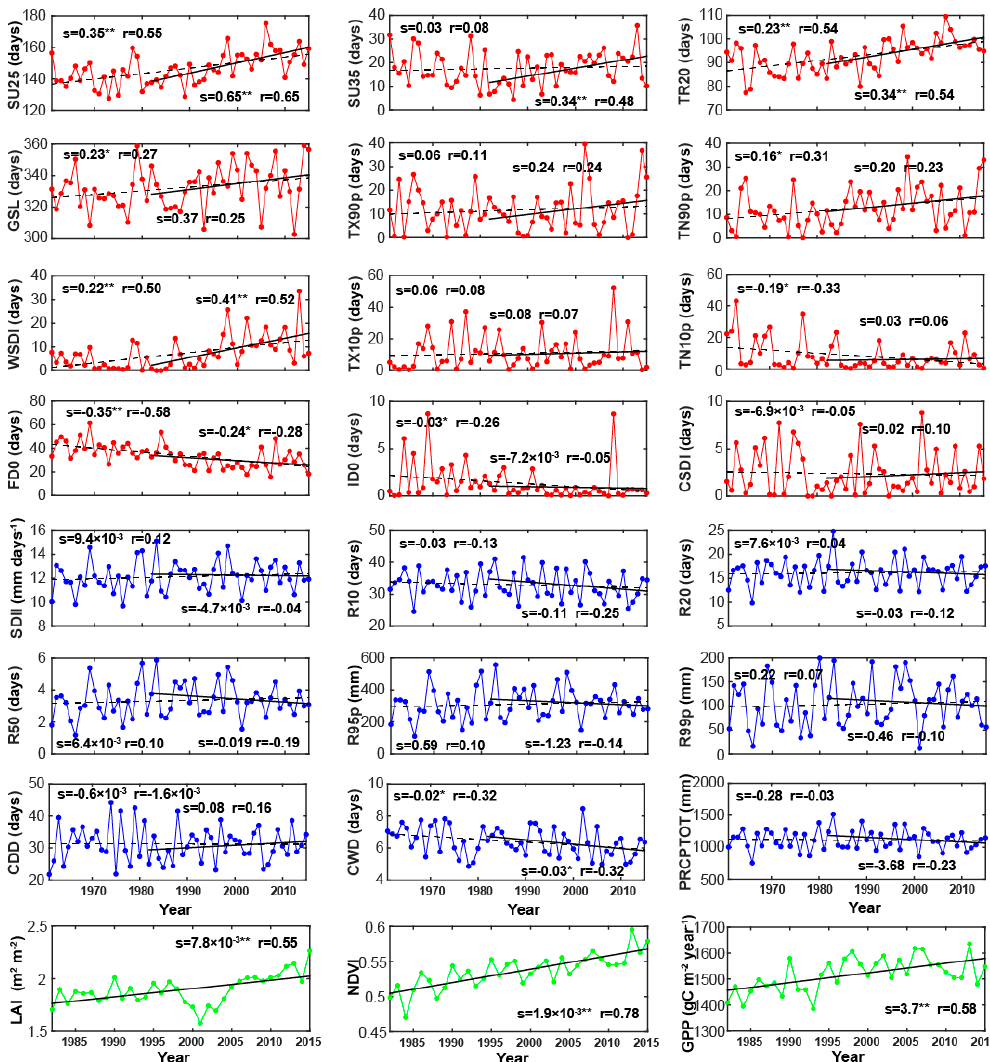
Figure 4. The temporal variations in temperature (red curves), precipitation (blue curves), and ecosystem (green curves) indicators in Hubei Province. In the legend, the letter s refers to the regression coefficient, and the letter r refers to the correlation coefficient. For the temperature and precipitation indices, the regression coefficient on the left and right are for the periods 1961–2015 and 1982–2015, respectively. Significance levels are denoted as follows: * p < 0.1 and ** p < 0.01. All three ecosystem indicators (i.e., LAI, NDVI, and GPP) for the whole study area show